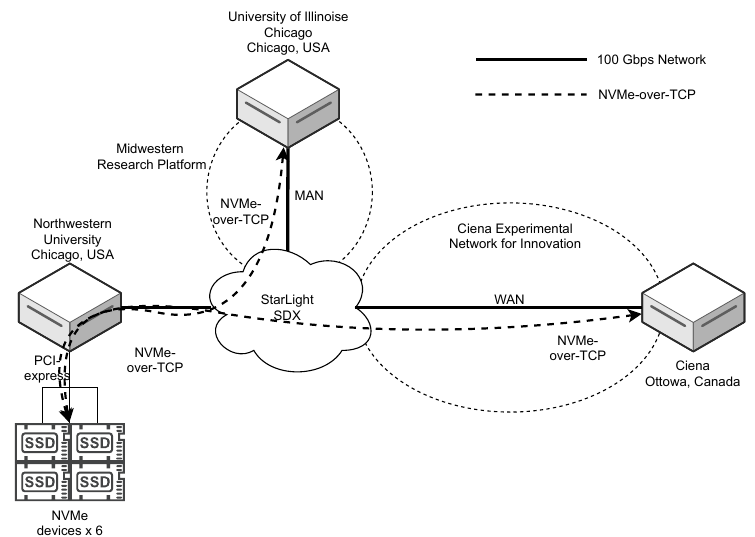
Figure 1. Experimental